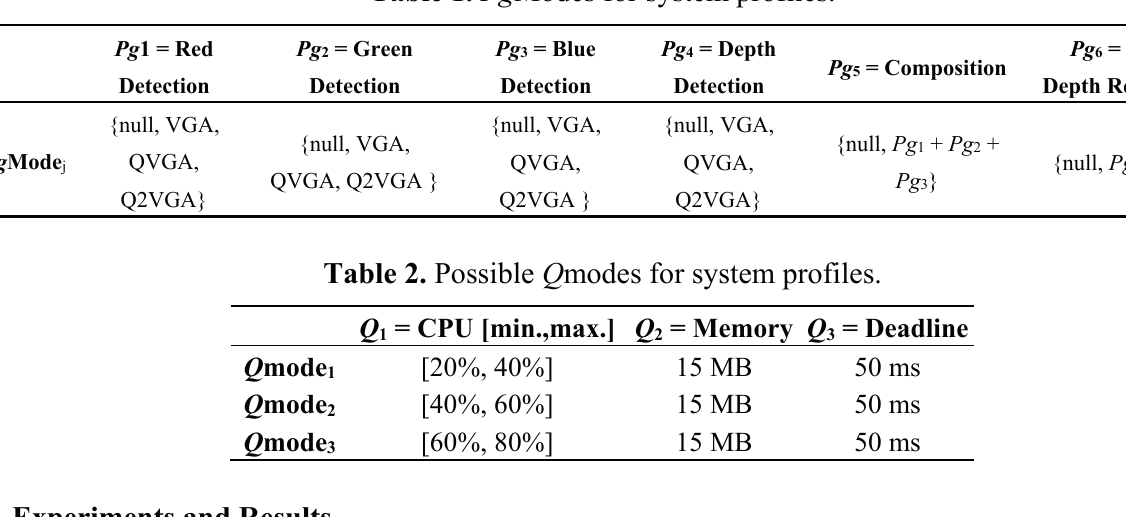
Table 1. Pg Modes for system profiles.